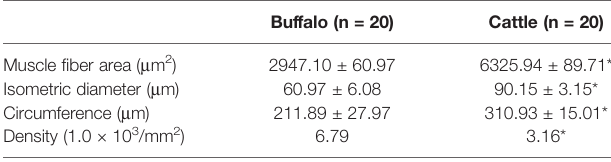
TABLE 2 | Histological analysis of longissimus dorsi muscle